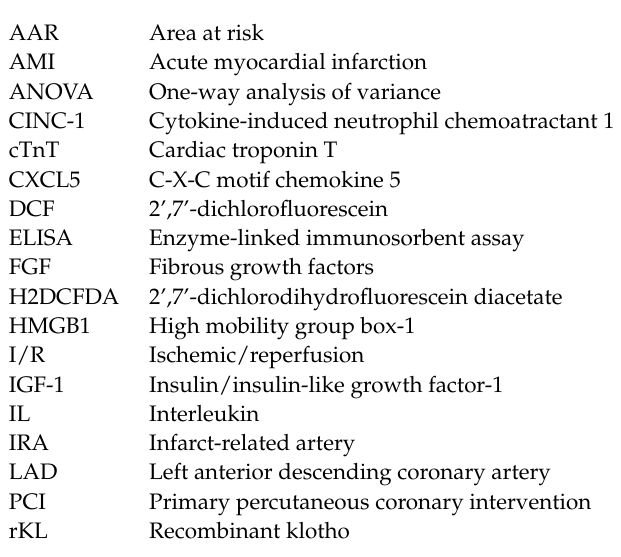
Study. Table S2: The Statistical Results for the Optimal Dose of Recombinant Klotho. Table S3: The Statistical Results of the Present